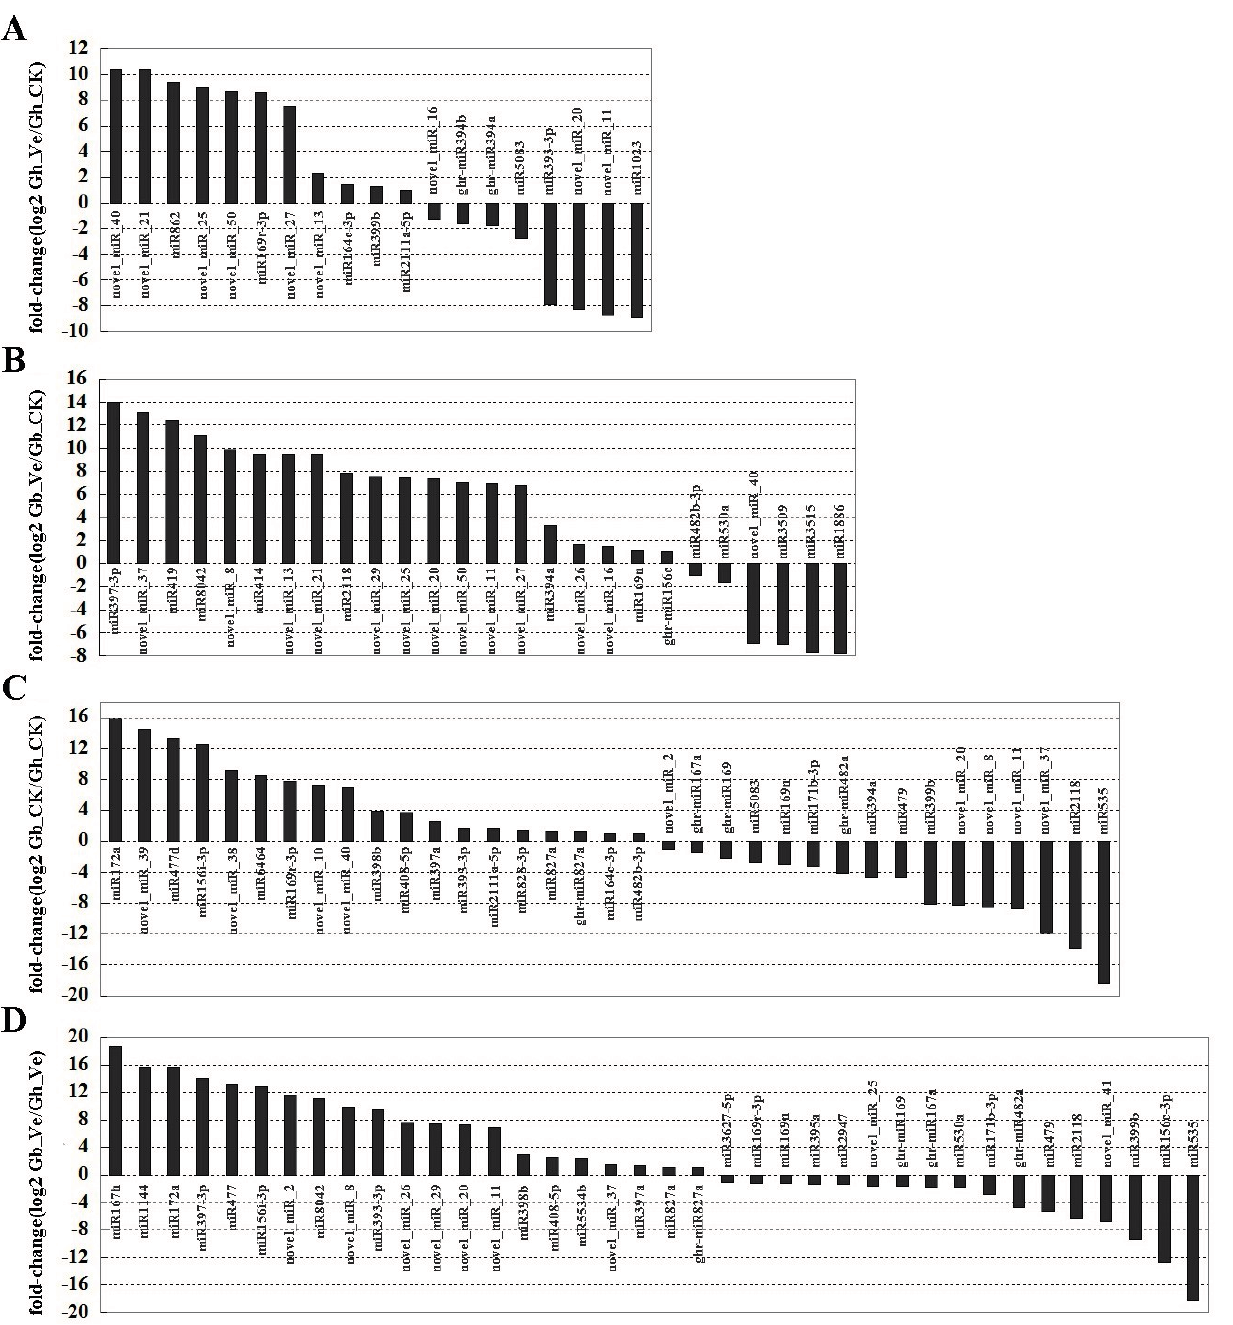
Figure 2. Expression profiles of differentially expressed miRNAs by high-throughput sequencing. ( A ) Differentially expressed miRNAs between Gh_Ve and Gh_CK